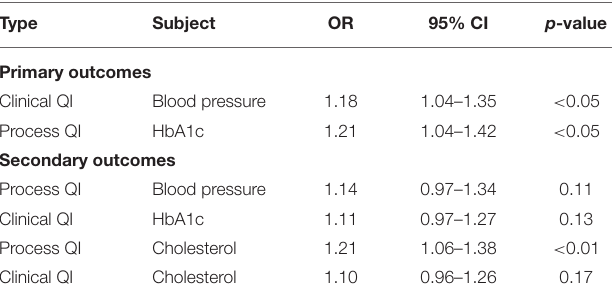
TABLE 3 | Interactive effect of time and intervention over the entire study period of 24